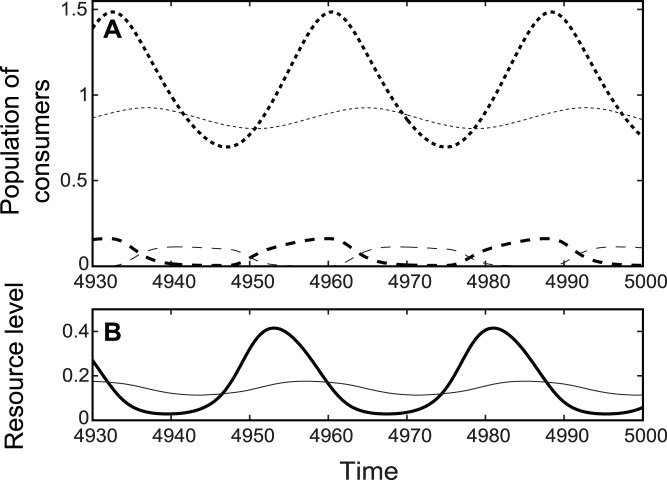
Population dynamics in environment 2 under fitness-dependent dispersal.Population dynamics of consumers (the upper panel, A) and the resource (the lower panel, B) in environment 2 (k
1 = 0.8, k
2 = 0.4) under fitness-dependent dispersal. (Bold solid line: R
1;thin solid line: R
2; bold dotted line: CS
,1;thin dotted line: CS
,2;bold dashed line: CI
,1; thin dashed line: CI
,2). The superior consumer moving capacity is low (d
max,S = 0.01), and the inferior consumer moving capacity is high (d
max,I = 100).